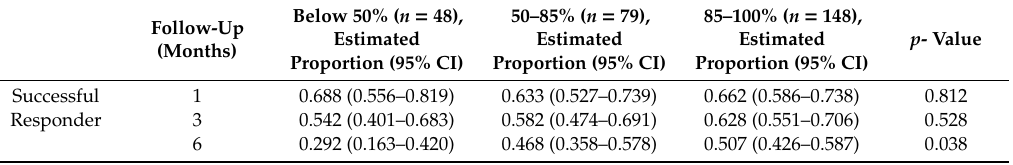
Table 3. Estimated proportions of successful responders among patients who were treated by the decompression and adhesiolysis using an inflatable balloon catheter.